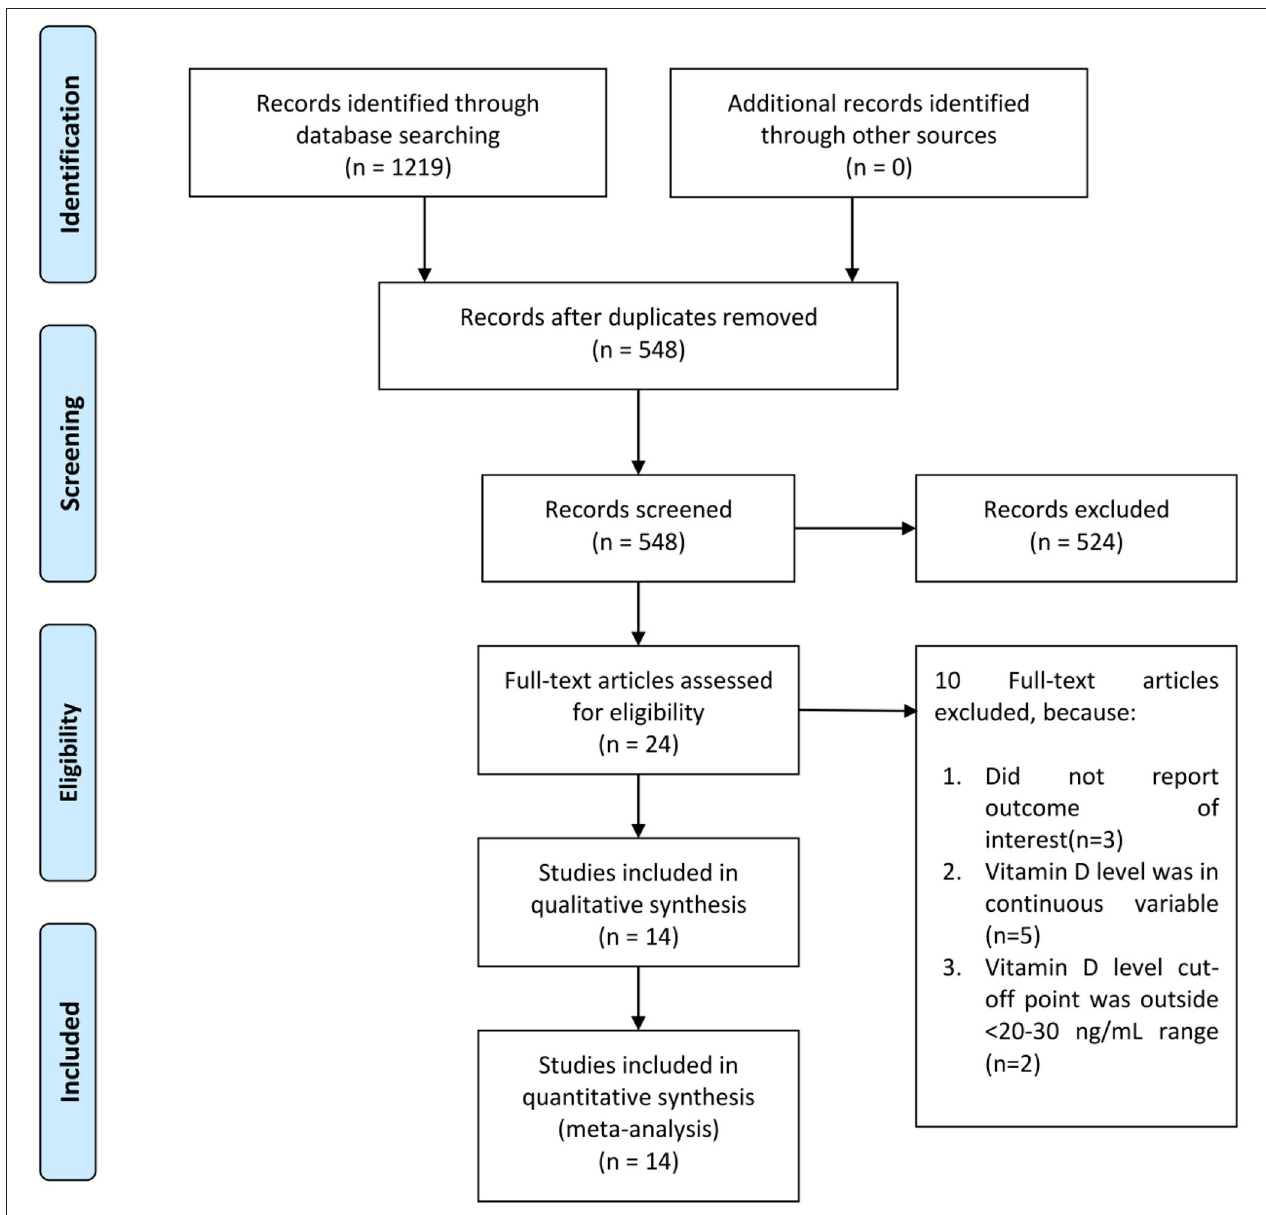
FIGURE 1 | PRISMA